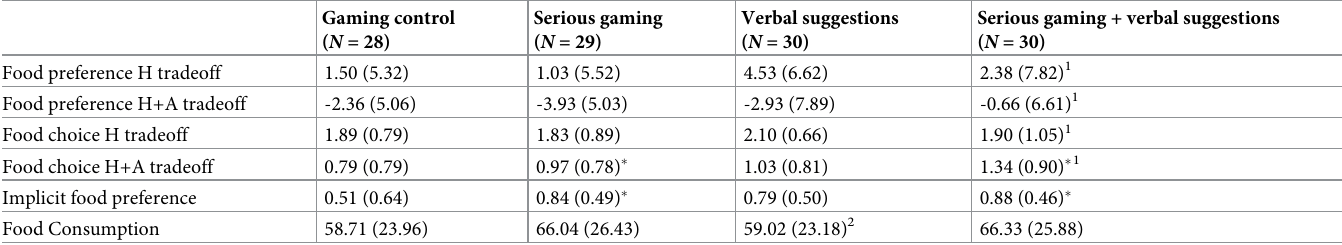
Table 2. Means and standard deviations of food-related outcome measures per